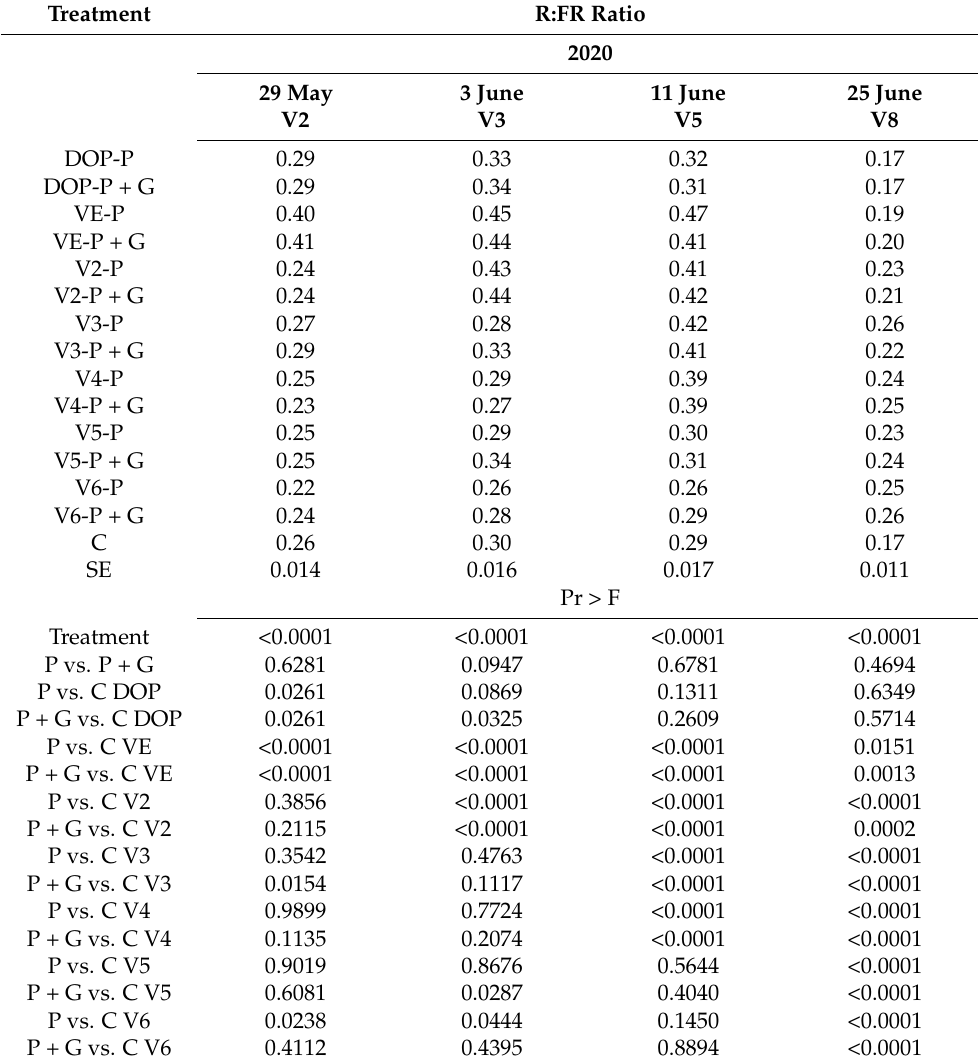
Table 2. Reflected R:FR ratio above perennial groundcover at the Sorenson Research Farm in 2020.